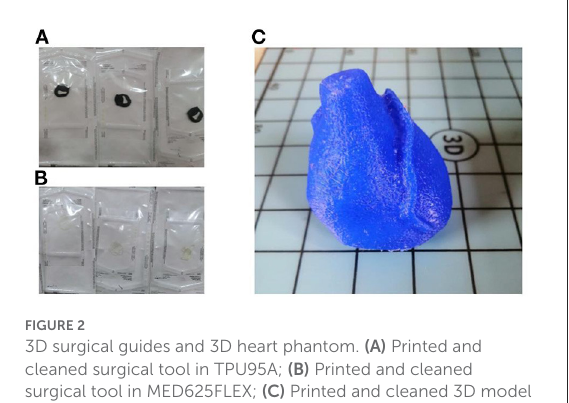
FIGURE2 3D surgical guides and 3D heart phantom. (A) Printed and cleaned surgical tool in TPU95A; (B) Printed and cleaned surgical tool in MED625FLEX; (C) Printed and cleaned 3D model of the phantom in